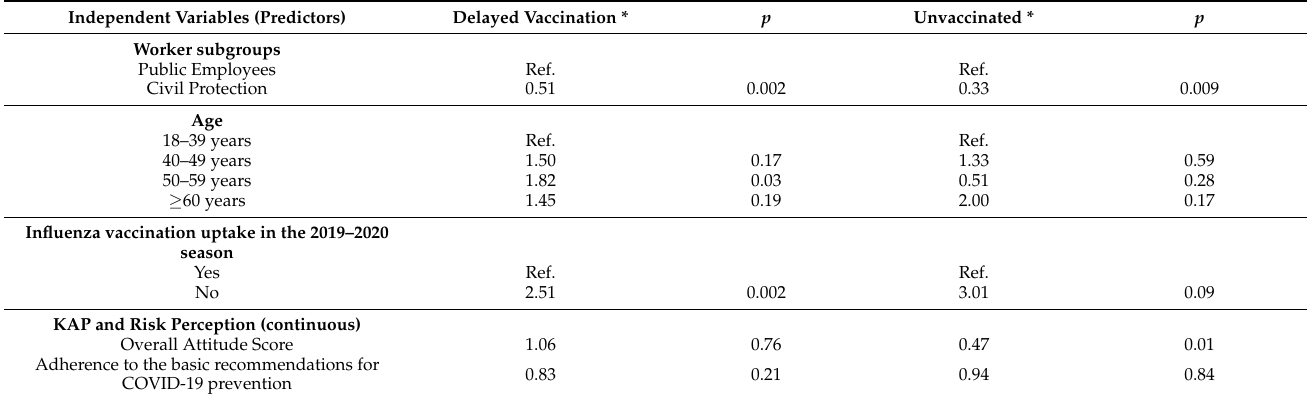
Table 5. Multinomial regression model: predictors of delayed vaccination and being unvaccinated for